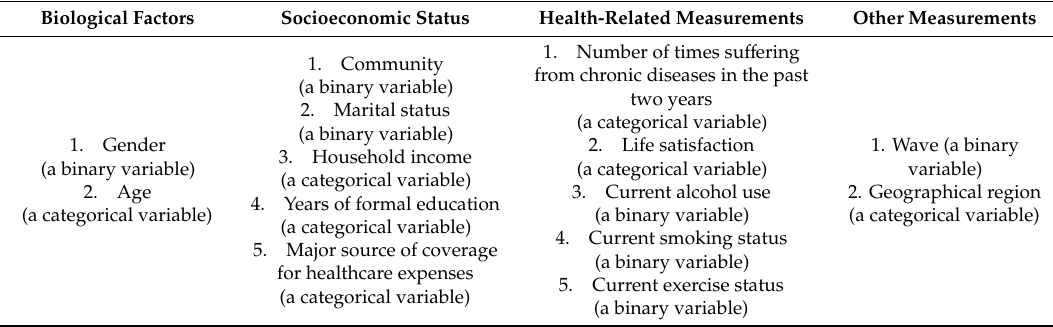
Table 1. Selected control variables for the final study